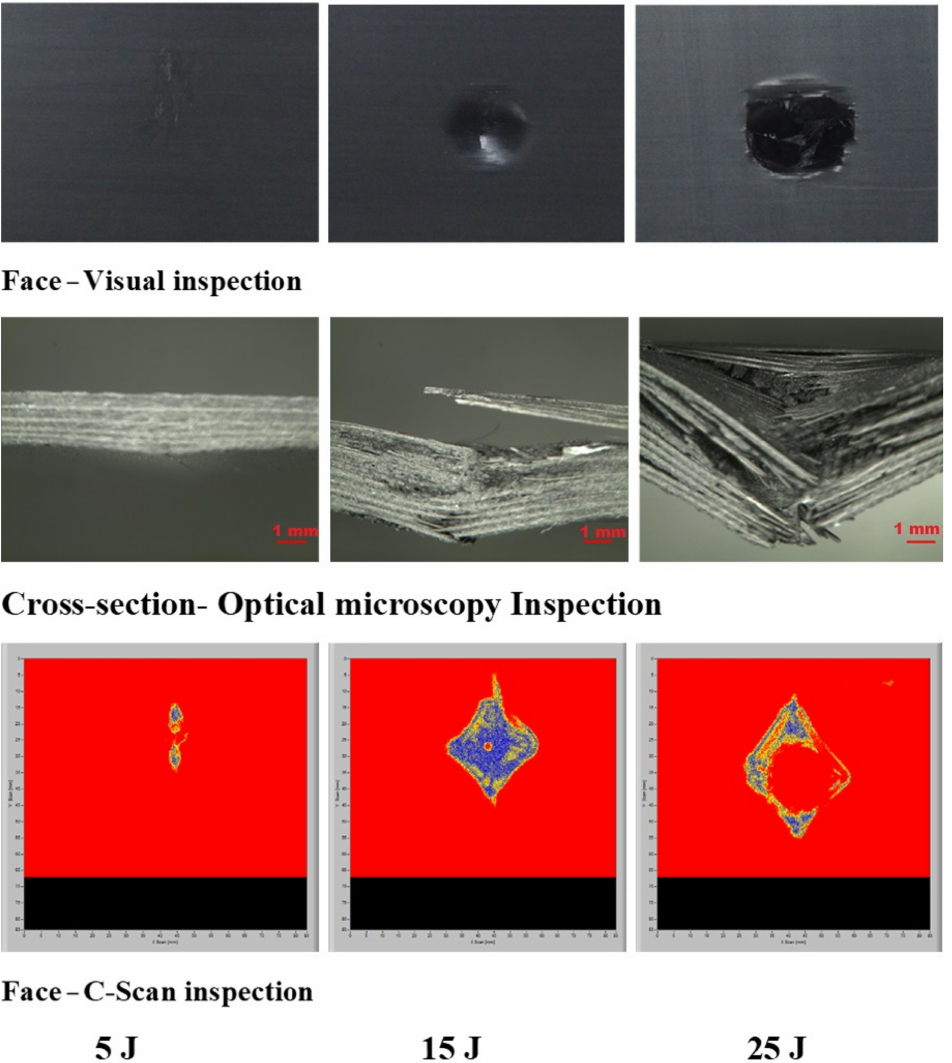
Figure 20. Pictures of the top surface view with C-scan and cross-section with optical microscopy of [A/B] at 5, 15, and 25